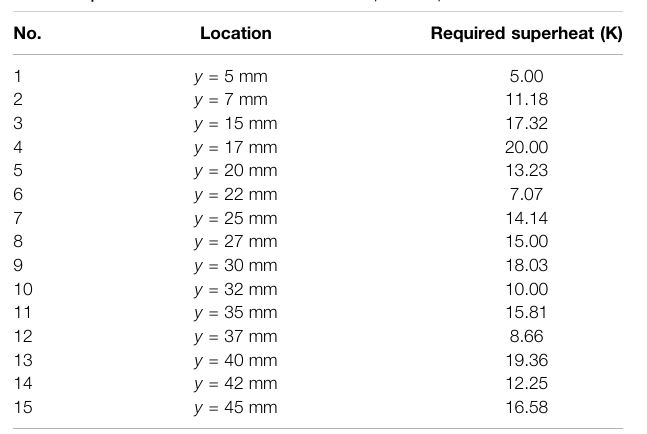
TABLE 2 | Locations of nucleation sites and required superheat.